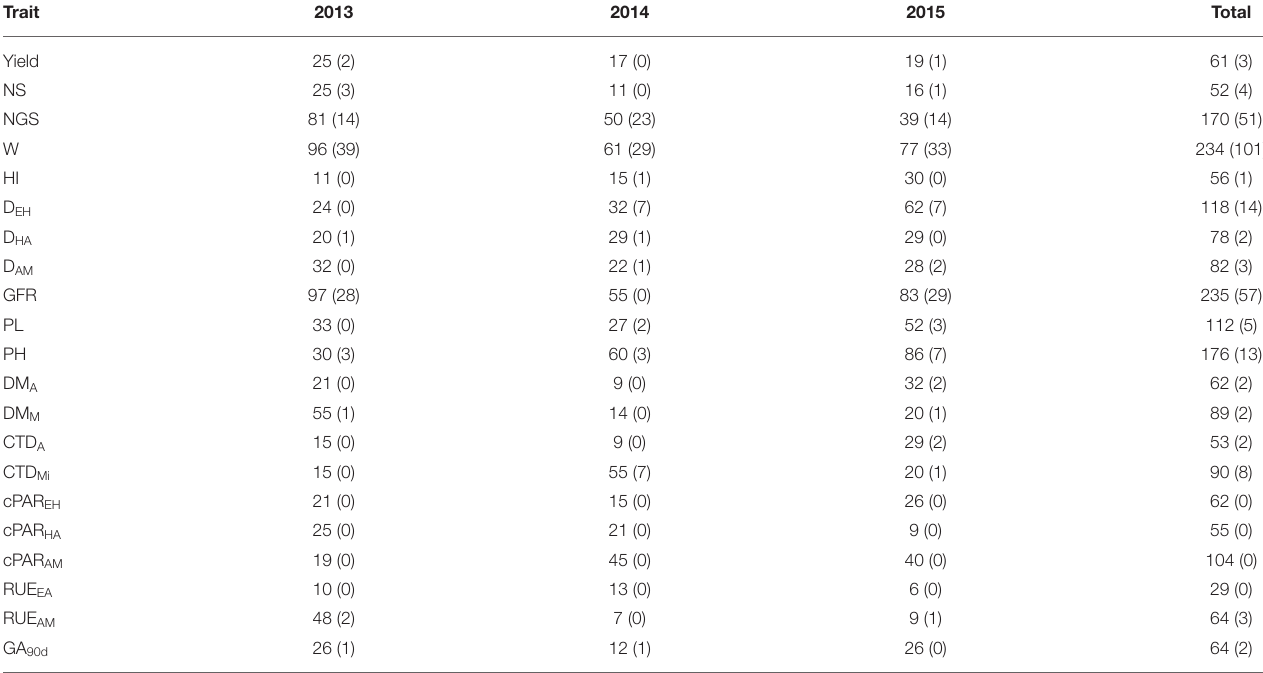
TABLE 4 | Number of MTAs per trait and year.